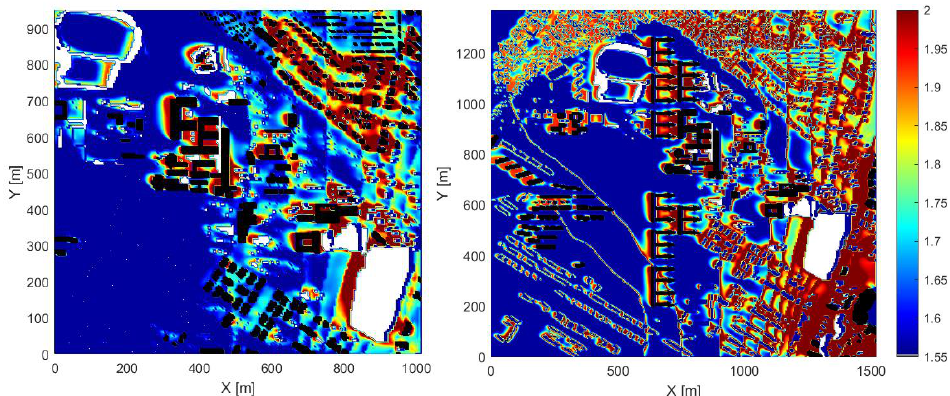
Figure 16. PMV [-]at pedestrian level: on the left, in the current situation; on the right, in the planned situation.